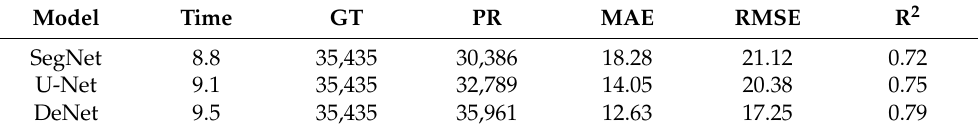
Table 2. The prediction results of three models assessed on the validation dataset.